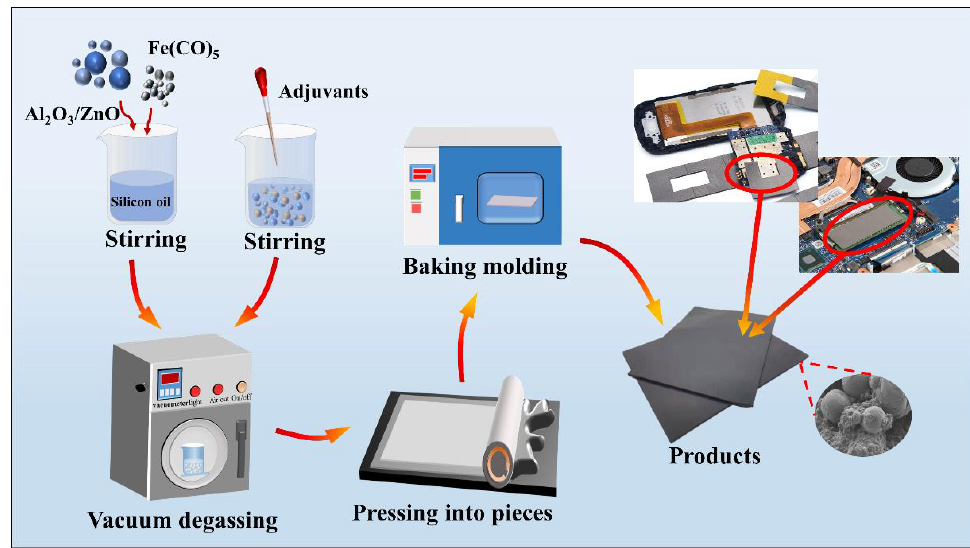
Figure 1. The schematic illustration of preparation process for Al 2 O 3 /ZnO/Fe(CO) 5 /SR composite